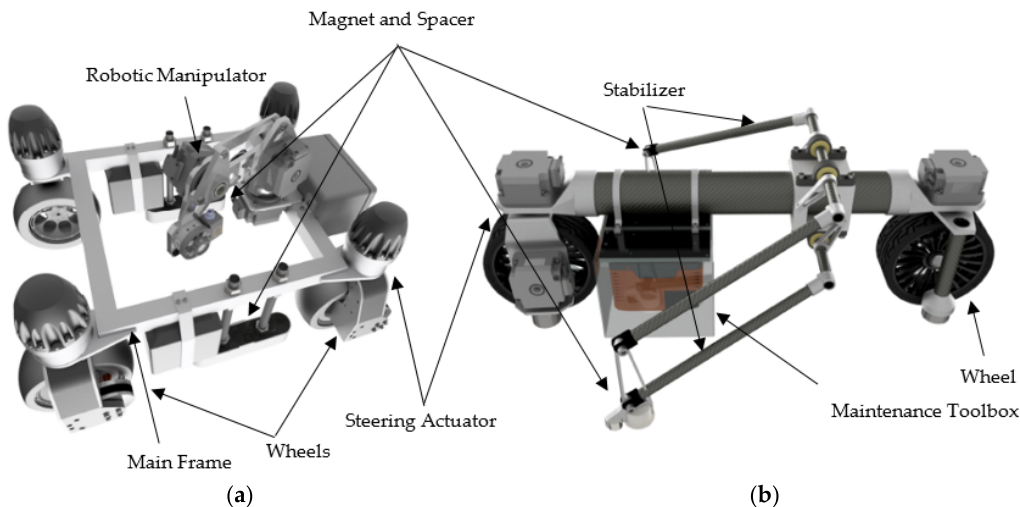
Figure 21. Concept of a four-wheel omnidirectional platform ( a ); concept of a two-wheel magnetic platform with stabilizers ( b ).